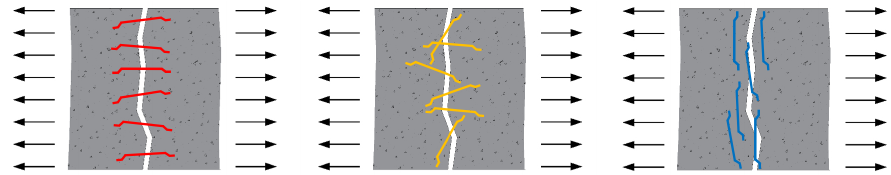
Figure 1. Indicative alignment of fibers in relation to tensile stresses and cracking in concrete, from left to right: most favorable, with fibers (red) aligned with the tensile stresses; random (yellow), leading to isotropic performance; and unfavorable (blue) with no fibers (effectively) bridging the